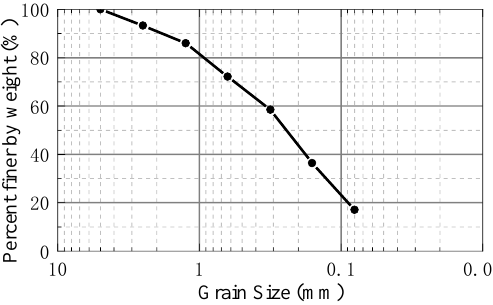
Figure 1. Grain size distribution curve of calcareous sand sample.